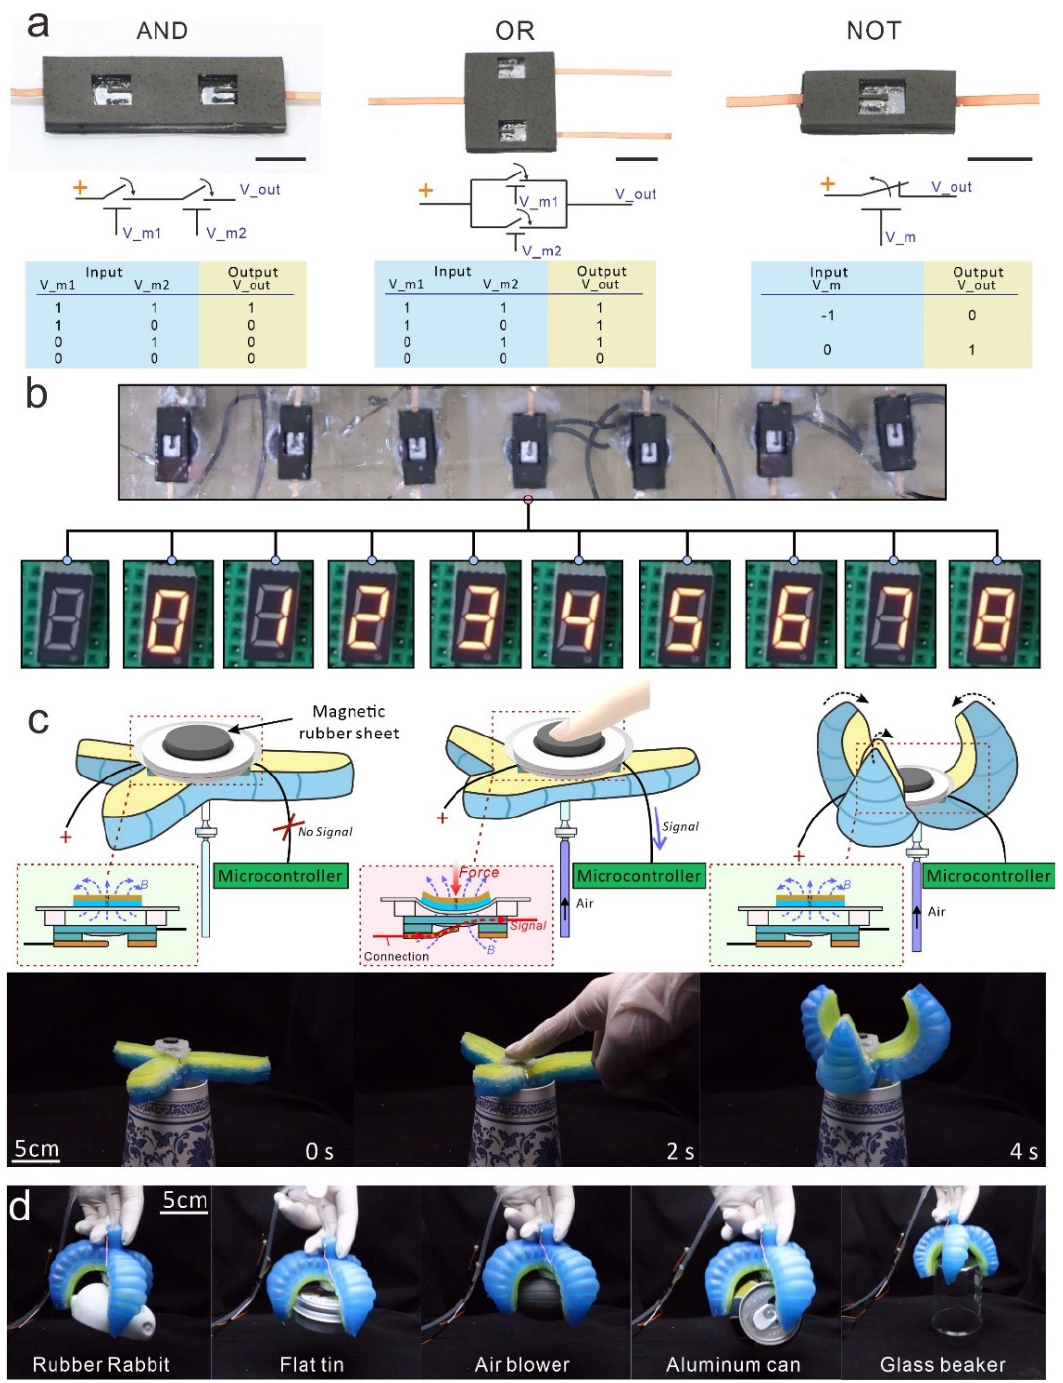
Figure 5. Demonstrations. ( a ) Logical units and truth tables with various MCSMs’ and electromagnets’ configurations. Scale bars = 5 mm. ( b ) A digital tube controlled by seven MCSMs shows various numbers. ( c ) Serial schematic and photos of a soft gripper contraction after a finger touches the MCSM. ( d ) Serial snapshots of the soft gripper integrated with an MCSM detecting and grabbing diverse objects.